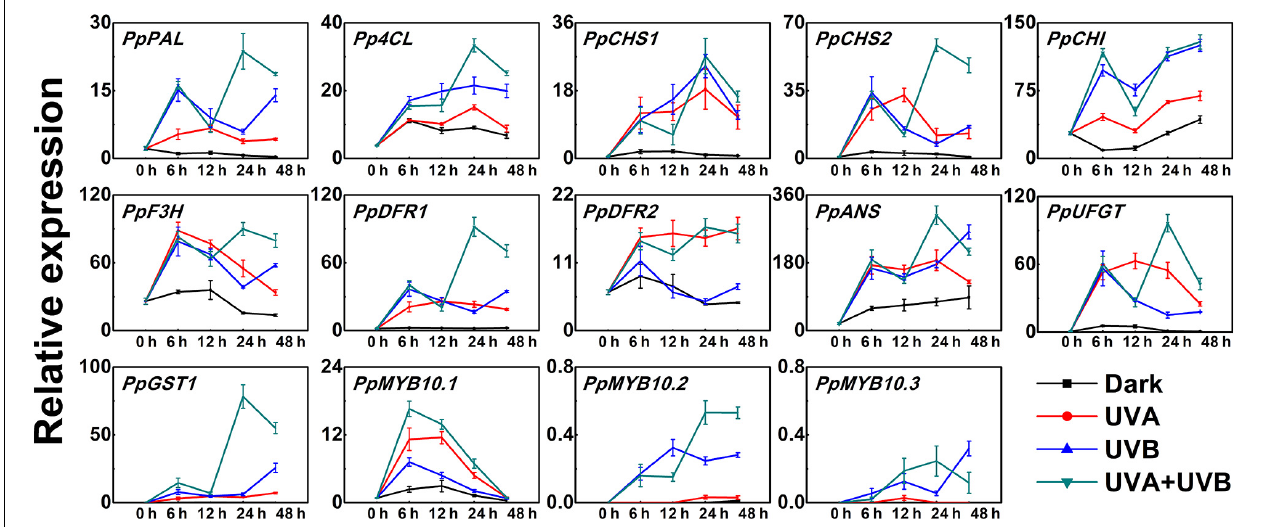
FIGURE 2 | Time course of the transcript levels of anthocyanin biosynthesis related genes in peach peel in response to continuous UV lights. UVA, 1,000 µ w/cm 2 ; UVB, 58 µ w/cm 2 . Data were presented as means ( ± SE) from three independent biological